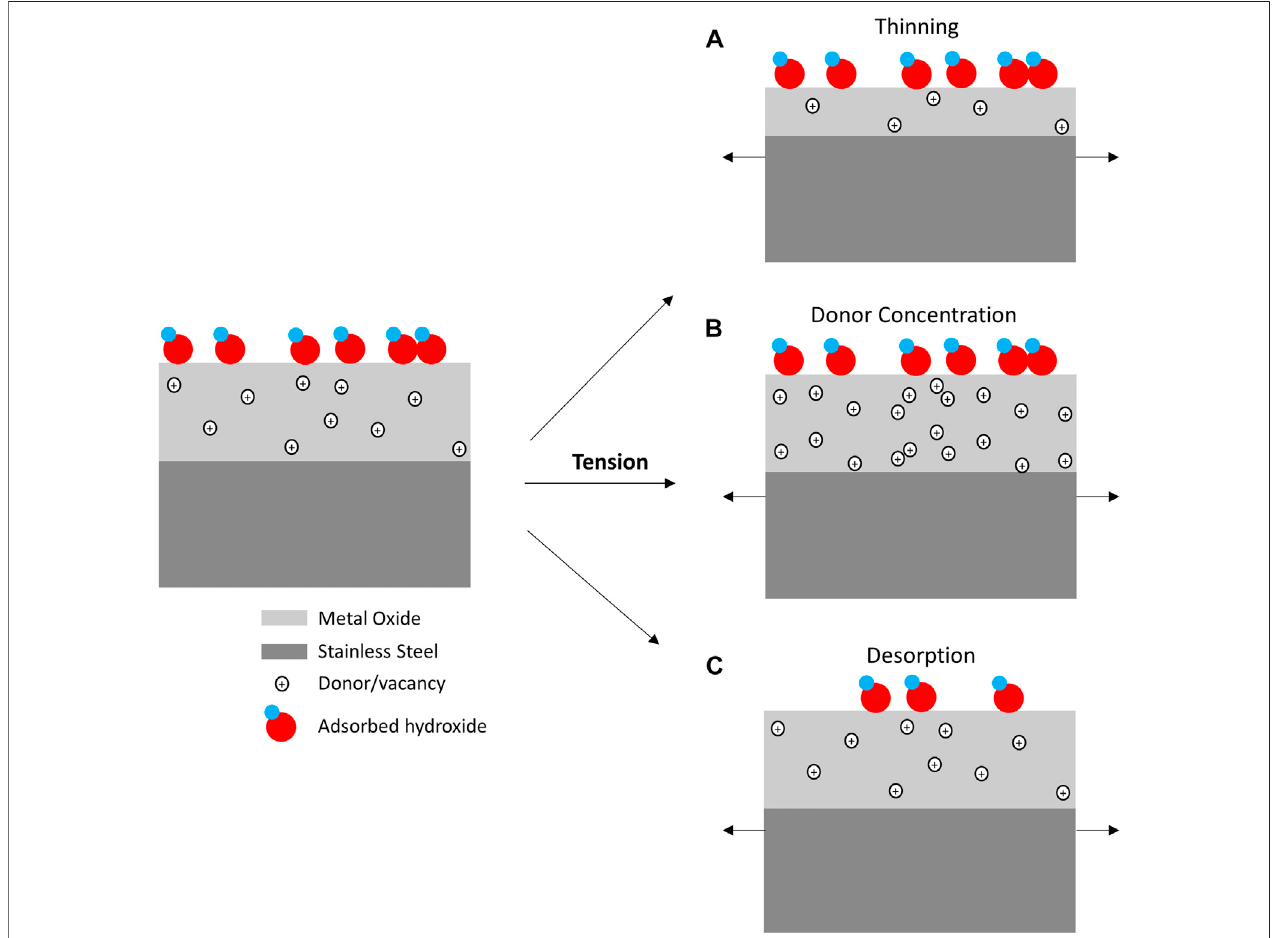
FIGURE 6 | Schematic of mechanisms that may impact reductive reaction rates going from an unstressed to tensile state include conductance changes from (A) oxide thinning and (B) donor concentration/mobility changes as well as rate changes from (C) ad/desorption phenomena.